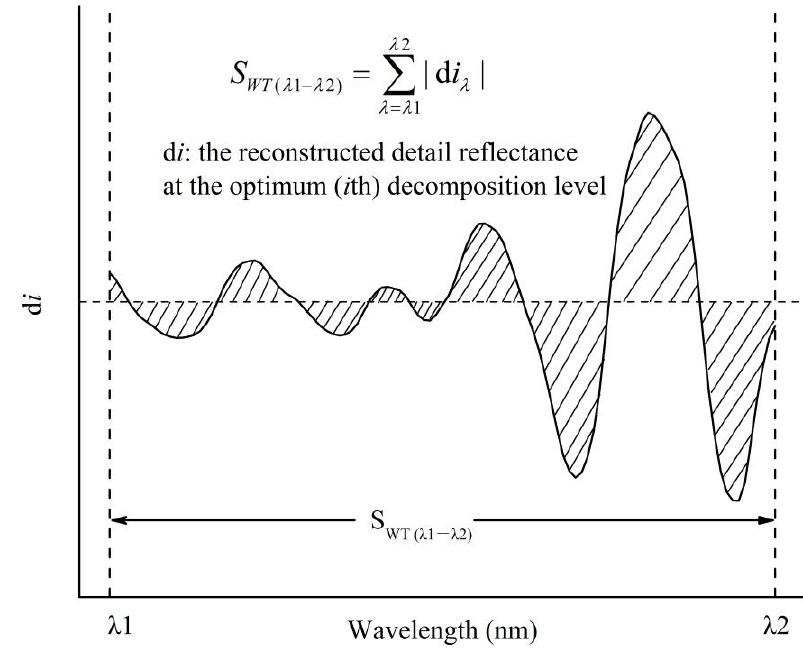
Figure 3. Wavelet-based area parameter S WT (λ1 − λ2) (absolute